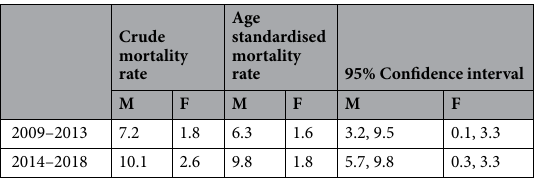
Table 5. Crude and age-standardised mortality rates by 15- and 5-year intervals for the top 4 categories of external causes of death. M males; F